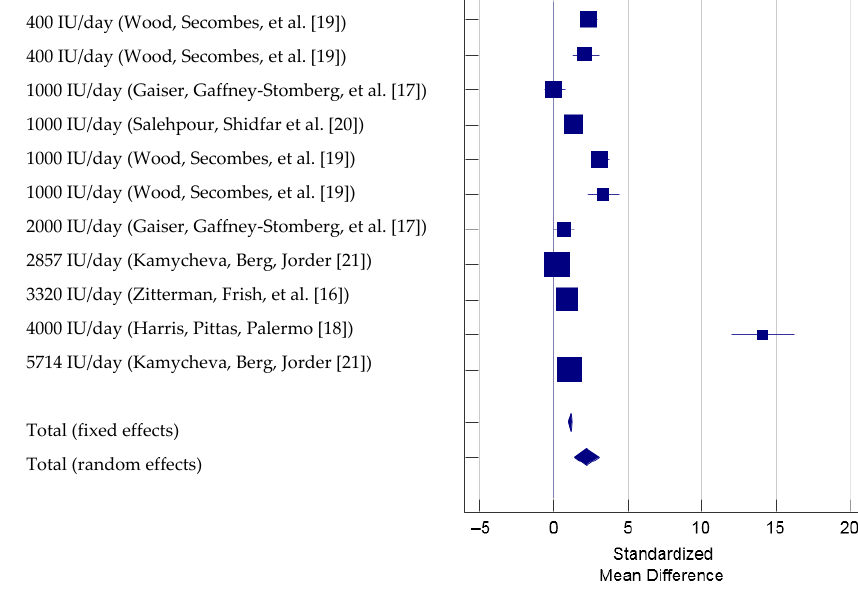
Figure 4. Forest Plot showing Standardized Mean Difference of 25OHD with vitamin D